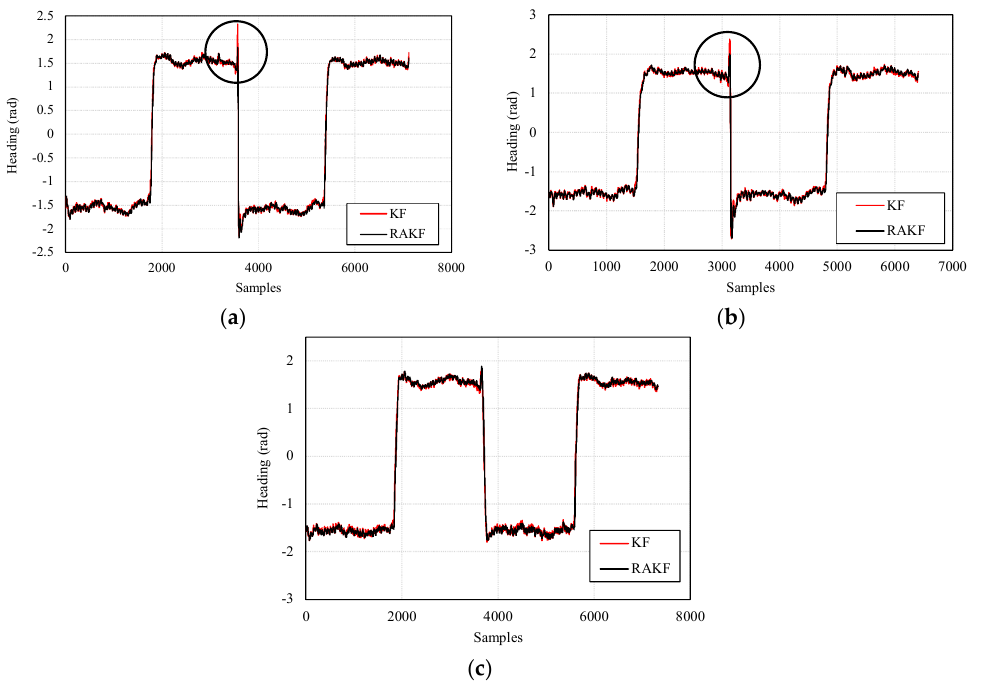
Figure 7. Comparisons of the performances on heading estimation of KF and RAKF with respect to three participants, ( a ) participant 1, ( b ) participant 2, and ( c ) participant 3.